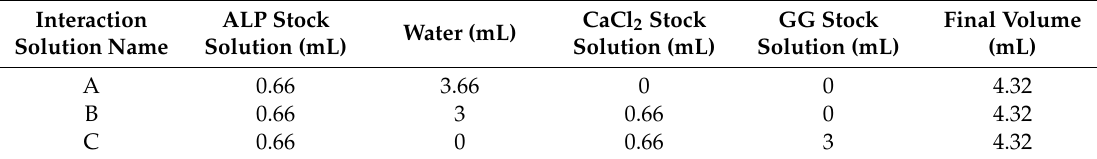
Table 1. Composition of interaction solutions used to study interactions between gallotannins and ALP. Interaction